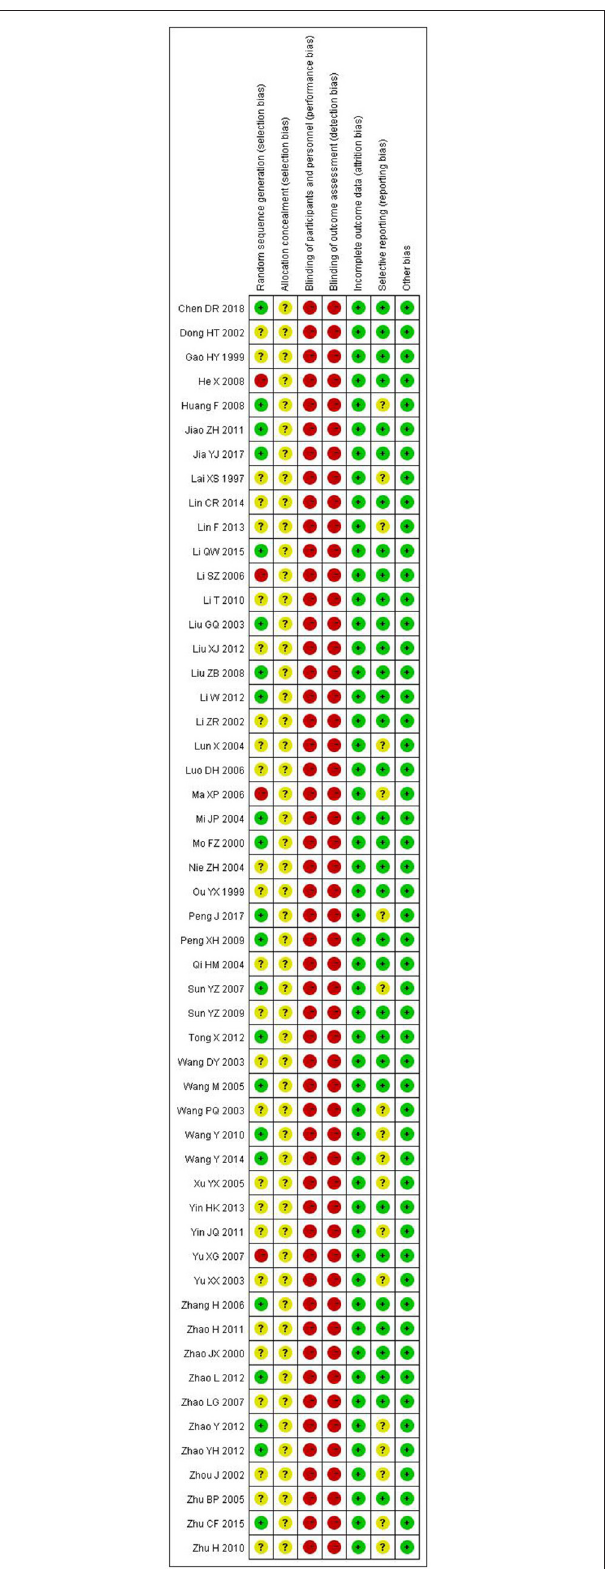
FIGURE 3 | Risk of bias